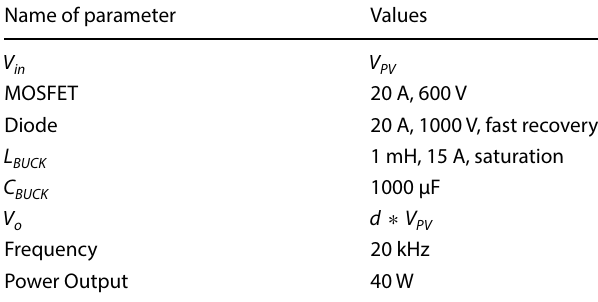
Table 3 Parameters of buck DC–DC